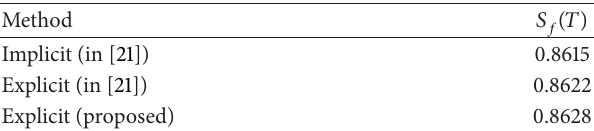
Table 3: Comparison with front-fixing method under transforma- tion